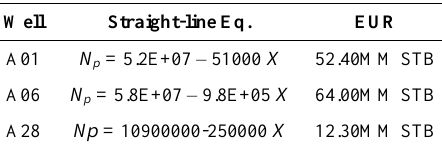
Figure 23. X-plot for well A28 Table 7. EUR from